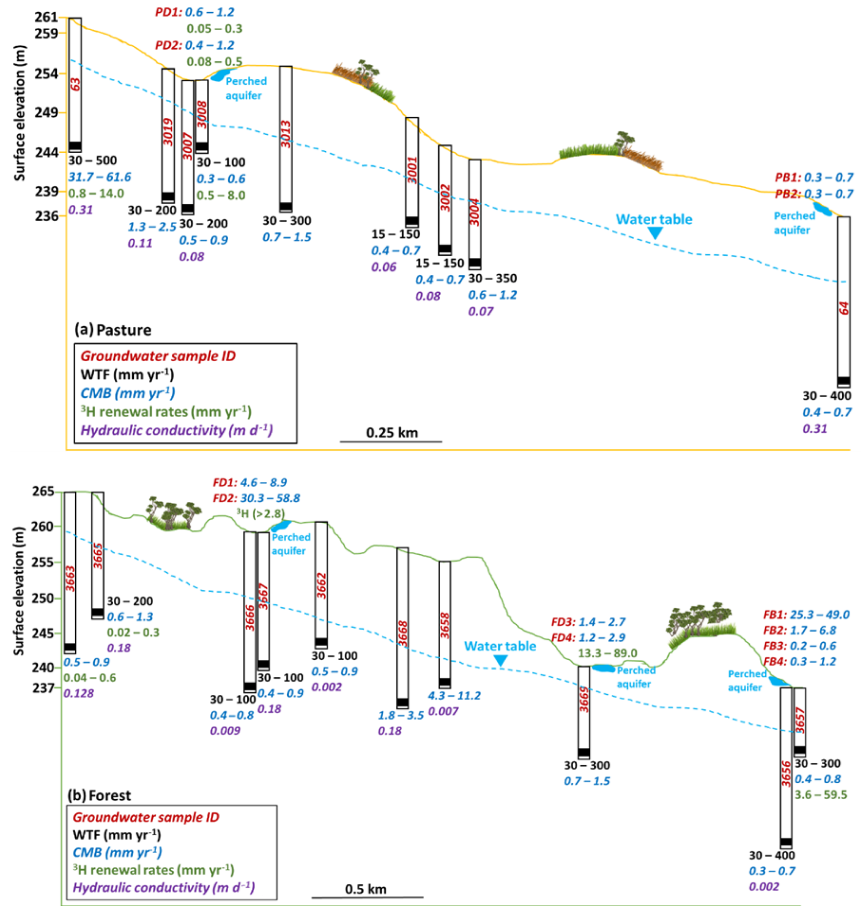
Figure 2. Simplified cross sections of (a) pasture and (b) forest catchments showing variability of groundwater recharge estimated via WTF, CMB, 3 H methods and variable hydraulic conductivity of the aquifer lithologies. Transects are in Fig. 1a. PD and FD represent the shallow groundwater in the pasture drainage and forest drainage areas, respectively. Data are from Table